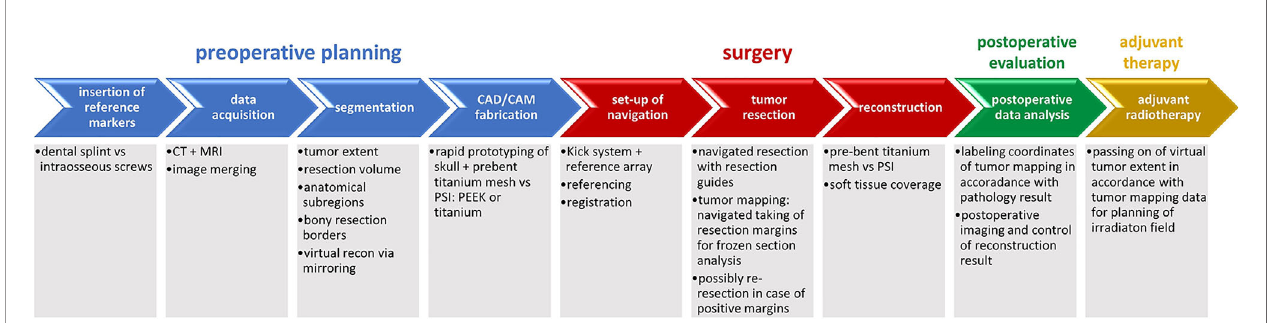
FIGURE 1 | Complete work fl ow of computer-assisted surgery. Computer-assisted surgery involving preoperative planning with data acquisition and processing including segmentation and virtual resection and reconstruction as shown in blue, surgery with real-time navigation, resection with tumor mapping and reconstruction